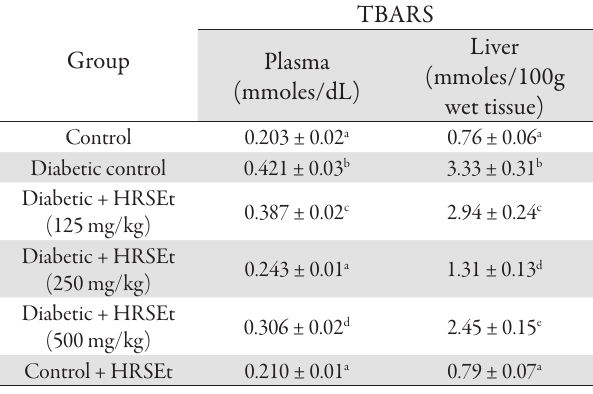
Tab. 5. The levels of plasma and tissues TBARS levels in control and experimental rats